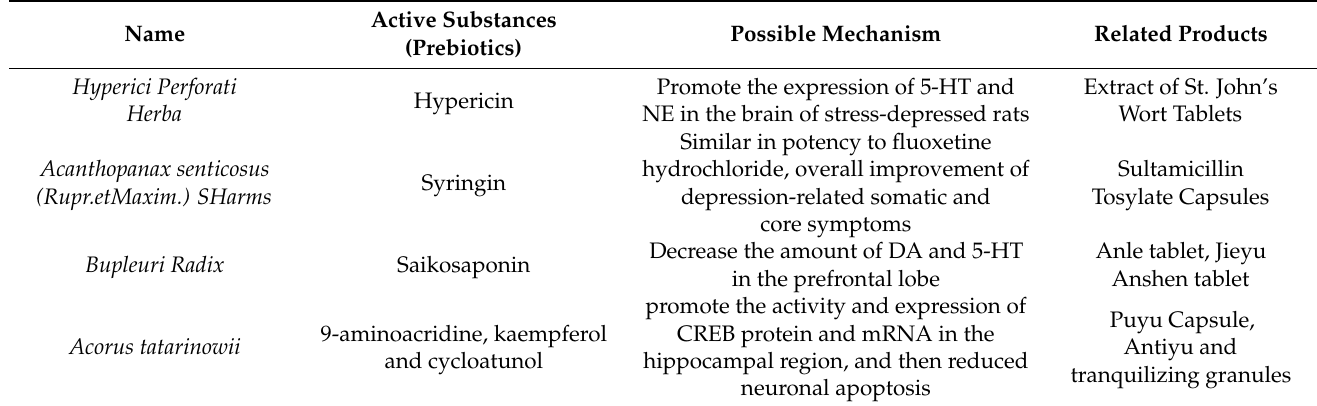
Table 2. Commercially available antidepressant products and their antidepressant